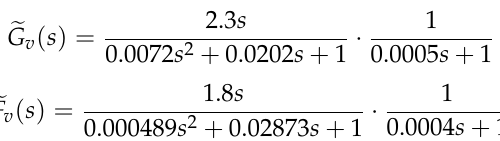
Figure 12. The open-loop bode responses of the velocity. ( a ) (cid:101) G v based on the FOG; ( b ) (cid:101) F v based on the virtual gyro.